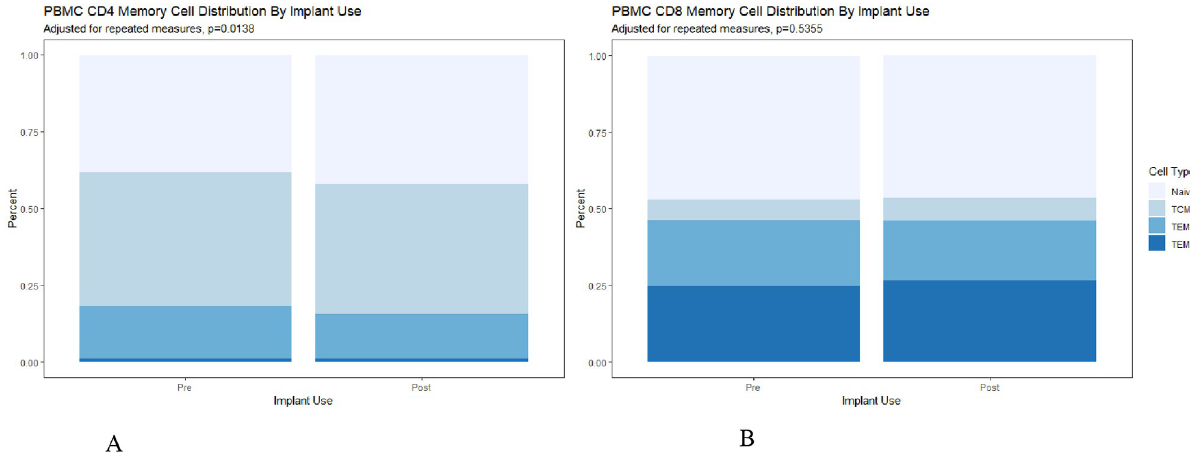
Fig 2. a. PBMC CD4 memory cell distribution before and after implant use, adjusting for repeated measures, p = 0.014. b. PBMC CD8 memory cell distribution before and after implant use, adjusting for repeated measures, p = 0.536. Memory cell phenotypes included Na ï ve T-cell (CD45RA hi and CCR7 hi ); Tcm = central memory T-cells (CD45RA lo and CCR7 hi ; Tem = effector memory T-cells (CD45RA lo and CCR7 lo ) and T EMRA = effector memory RA expressing T-cells (CD45RA hi and CCR7 lo ).